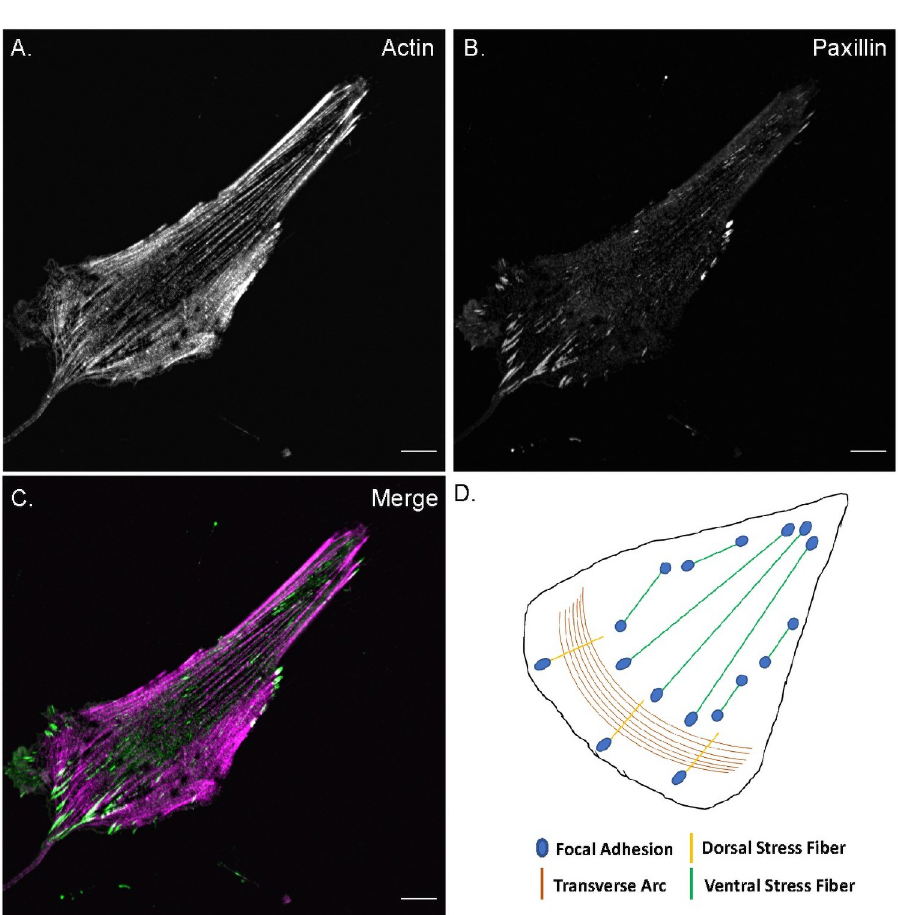
Fig 1. Stress fibers and focal adhesions. Confocal fluorescence microscopy images of an MRC5 cell stained for A) actin filaments (phalloidin) and B) focal adhesions (paxillin). C) Merged color image of the cell with actin filaments in magenta and adhesions in green. All images are of the ventral plane of the cell, scale bar—10 μ m. D) Schematic illustration of different stress fiber subtypes and their association with focal adhesions.